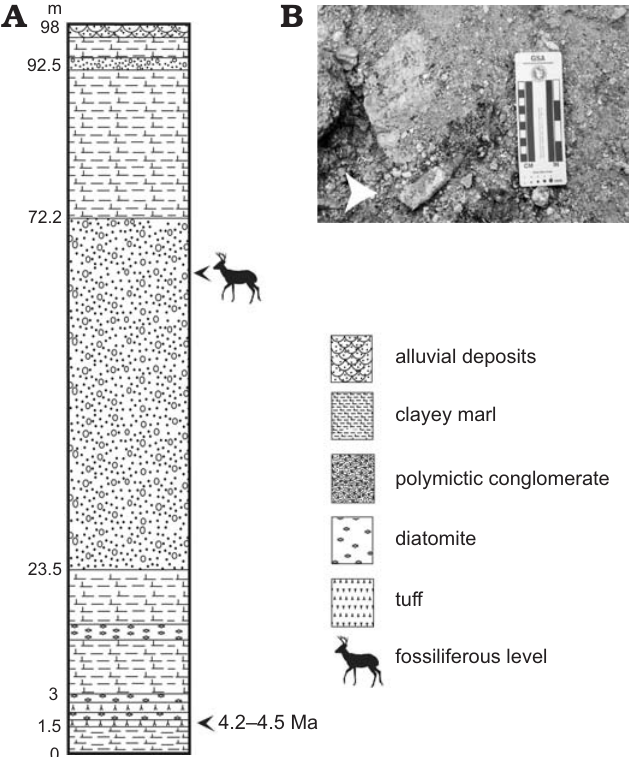
Fig. 2. A . Stratigraphic column of the fossil locality at Santa María Amajac. B . Field photograph of the UAHMP 481 (left mandible).